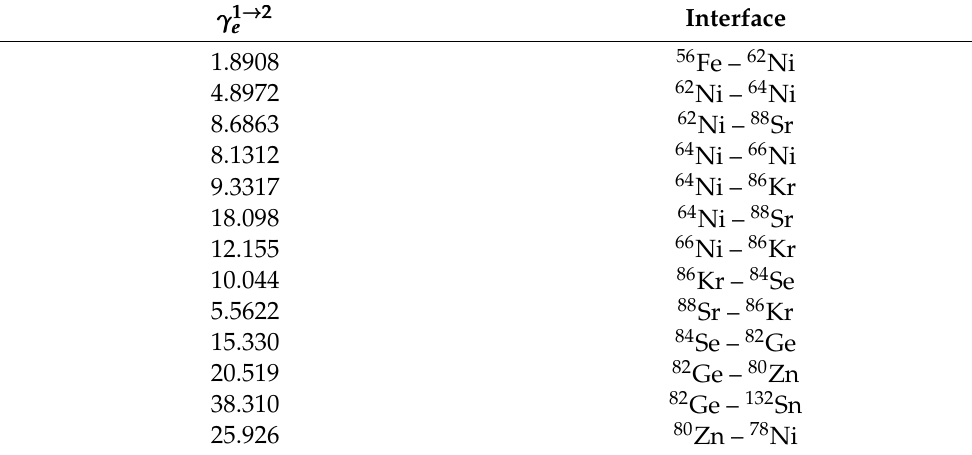
Table 3. Values of the nuclear parameter γ 1 → 2 e from which the pressure and the densities at the boundary between adjacent layers in the outer crust of a magnetar can be